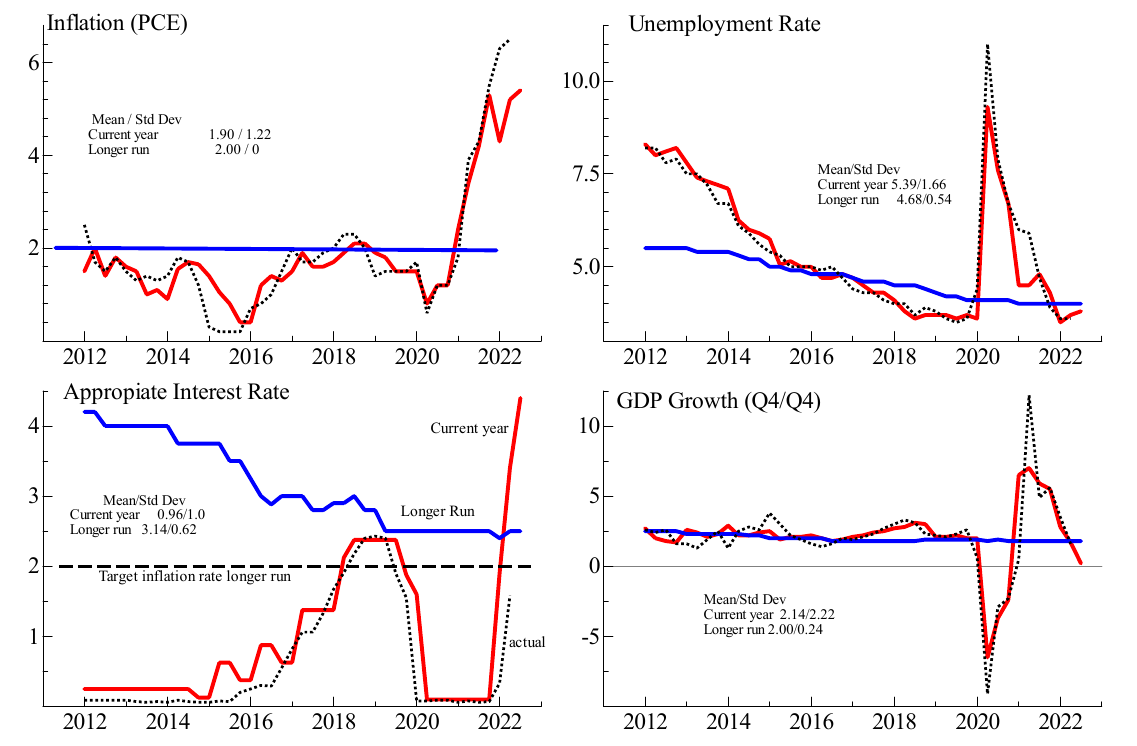
Figure 9. Median of longer-run forecasts, current year forecasts, and actual data. Red lines are the median of the distributions of the FOMC’s current-year forecasts; the blue lines represent the median of the distributions of the FOMC’s longer-run forecasts; the black short-dashed line represents the evolution of the recorded values; the black long-dashed line represents the FOMC’s longer-run forecast of the inflation rate.